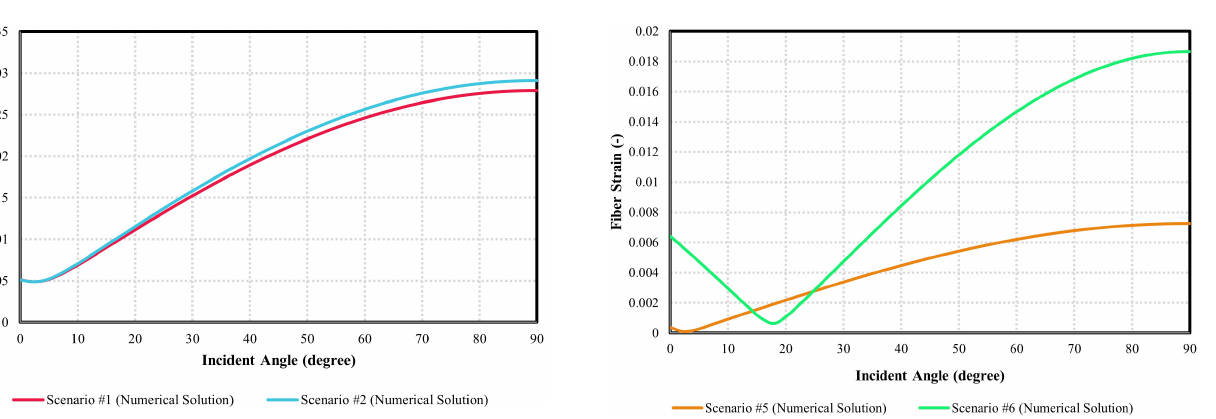
Figure 11. Investigation of the effect of cement quality (soft ver- sus hard) surrounding the casing on the acoustic response of fibre (comparison between scenarios 1 and 2).